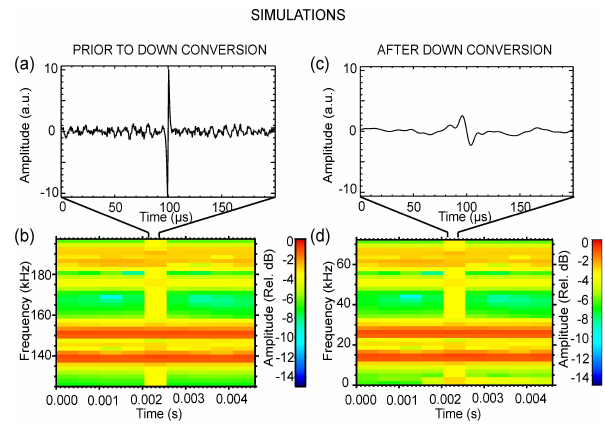
Fig. 5. Simulated data both before and after down conversion for comparison to space observations shown in Fig. 2. (a) 200µs sample of the input waveform showing the 5µs constructed pulse, as well as sinusoidal oscillations and background noise, prior to down con- version. (b) 5ms time–frequency spectrogram of the simulated data shown in (a) . (c) 200µs sample of the waveform presented in (a) , after having been down-converted from the frequency range 125– 202kHz to baseband; the sinusoidal waves have been smoothed out and time dilated by the process, and the pulse has been reduced in amplitude, and broadened in time, consistent with the effects of the 77kHz band filter. (d) 5ms time–frequency spectrogram of the down-converted waveform in (c) showing the broad band associ- ated with the pulse, as well as the sinusoidal waves on the down- converted frequency